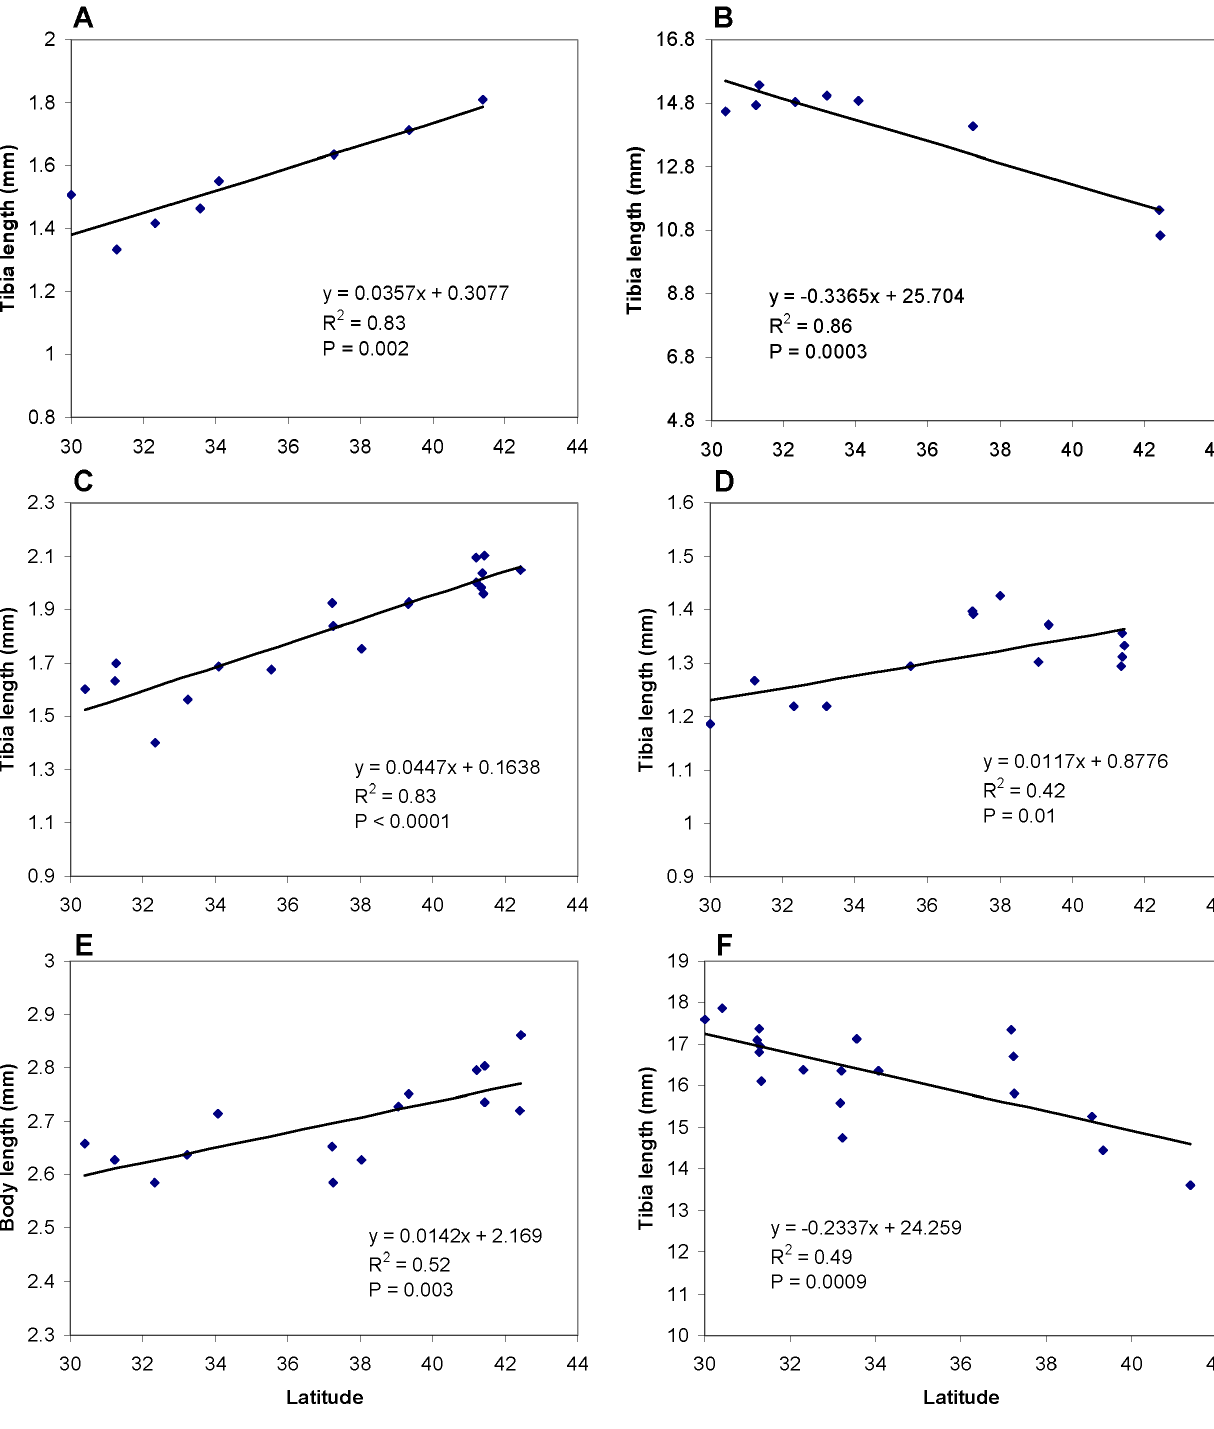
Figure 3. Patterns of herbivore body size in the field. Latitudinal variations in body size of U. pieloui and Paroxya on Solidago plants (A, B), U. ambrosiae and Ophraella on Iva plants (C, D), and Prokelisia and Orchelimum on Spartina plants (E, F). Each point represents a single study site.